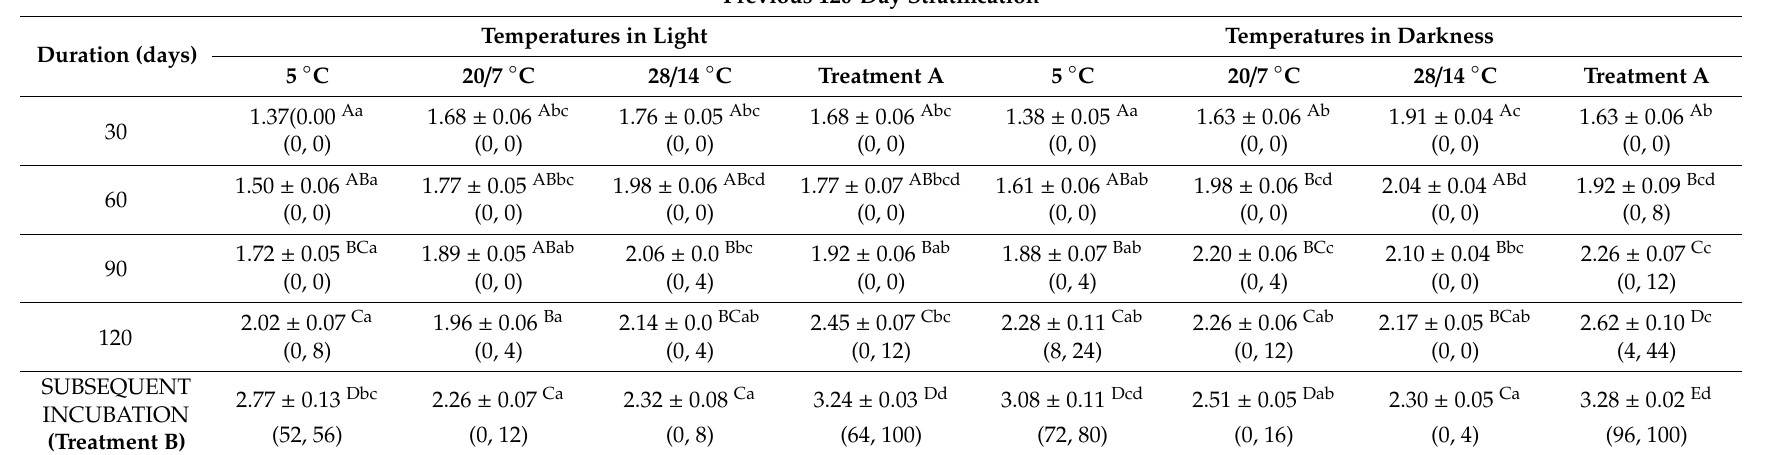
Table 2. Embryo length (mm, mean ± standard error) in N. nevadensis seeds after di ff erent periods of stratification and di ff erent temperatures in the light and